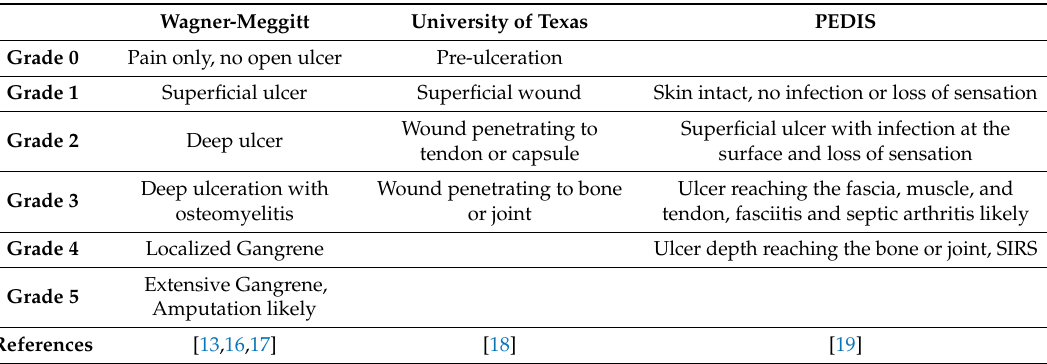
Table 1. Major classification